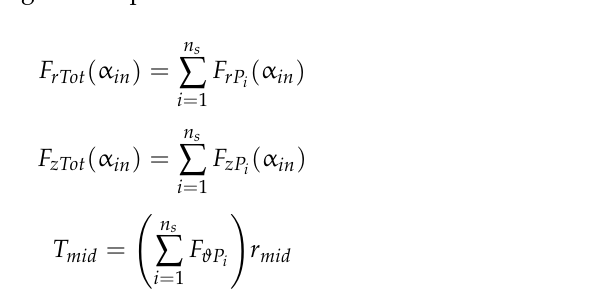
, , ,) of MG 2 ( a ) in reference to single pole piece no. P 1 , ( b – d ) for all cores P 1 –P 11. 𝐹𝐹 𝑟𝑟 𝐹𝐹 𝜗𝜗 𝐹𝐹 𝑧𝑧